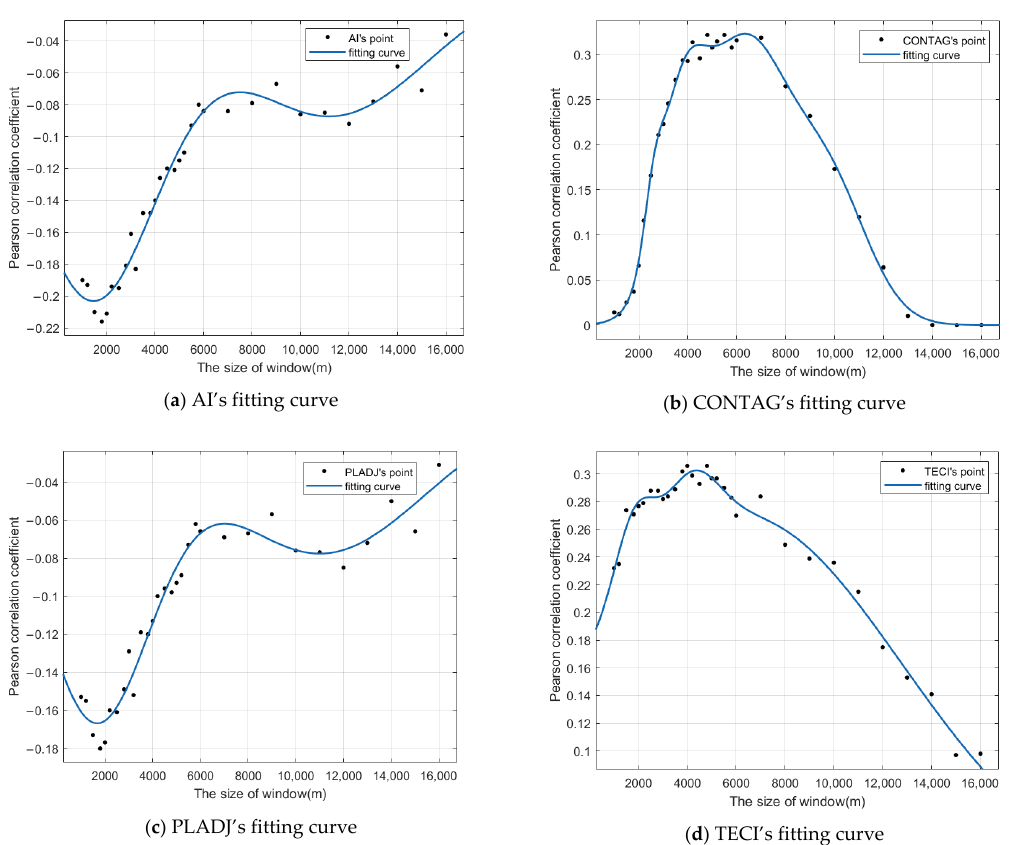
Figure 4. Fi tt ing results of correlation coe ffi cient between Gaussian landscape index and land sur- Figure 4. Fitting results of correlation coefficient between Gaussian landscape index and land surface face temperature. The subplot contains the results of di ff erent landscape indices. temperature. The subplot contains the results of different landscape The scale e ff ect of correlation between Gaussian landscape indices and land surface temperature is also obvious [40], as shown in Figure 4. The aggregation index (AI) and percentage of like adjacencies (PLADJ) exhibit similar correlation scale e ff ects with land